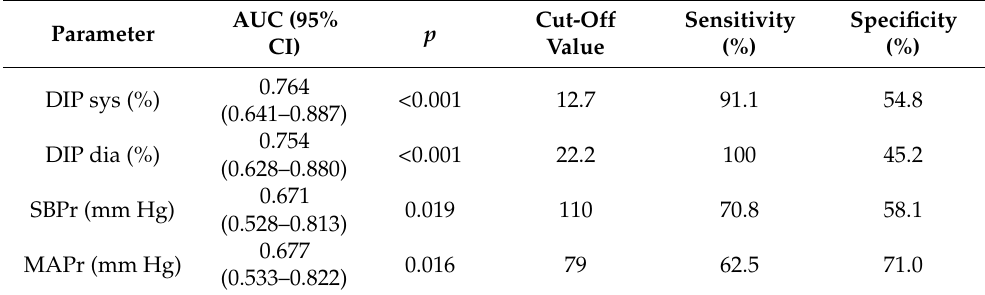
Table 4. Diagnostic accuracy of predicting annualized eGFR slope ≥ 3 mL/min/1.73 m 2 /year. SBP and DBP dipping acting as destimulants and DBPr and MAPr acting as stimulants.